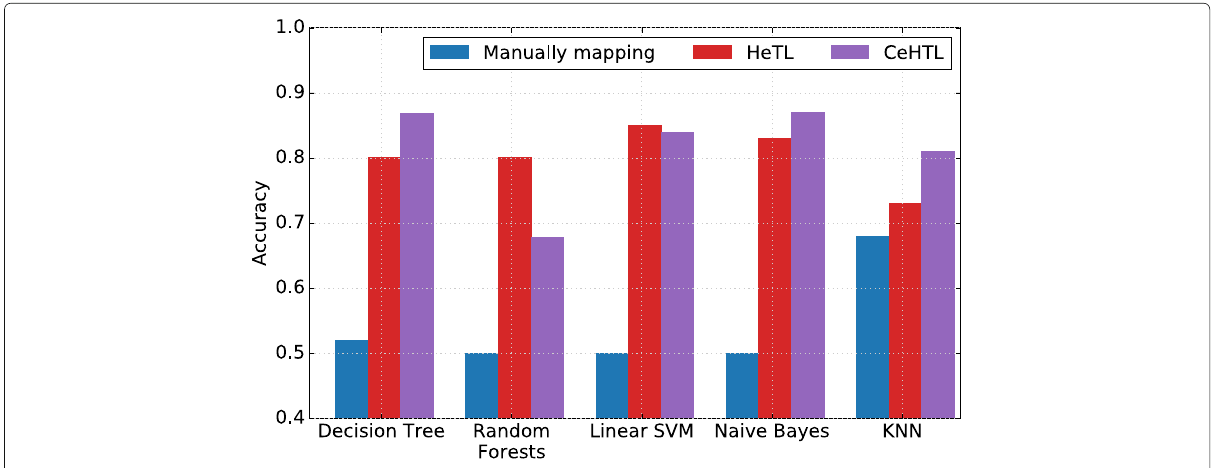
Fig. 8 Performance comparison on heterogeneous spaces on DoS →